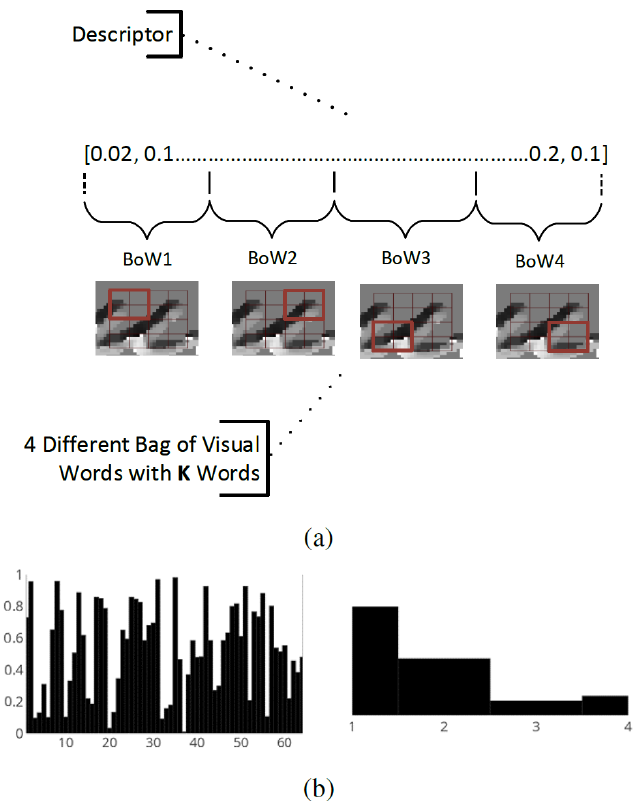
Figure 8. ( a ) The visual representation for the descriptor quantization using four different Bag of Visual Words; ( b ) the descriptor histogram, before and after applying